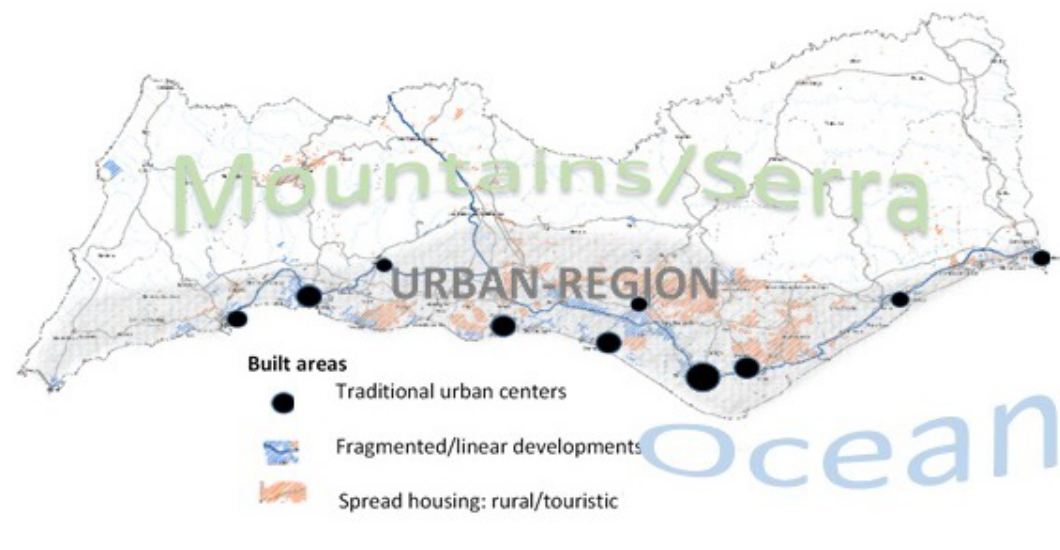
Figure 12: The urban-region of Algarve. Main components and barriers; spectral